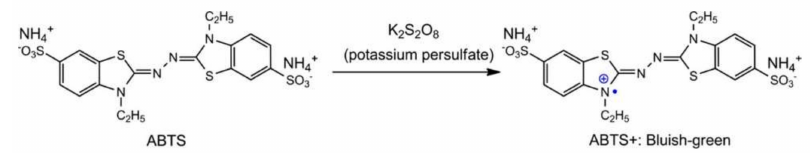
Figure 4. Changes in the ABTS radicals with potassium persulfate.